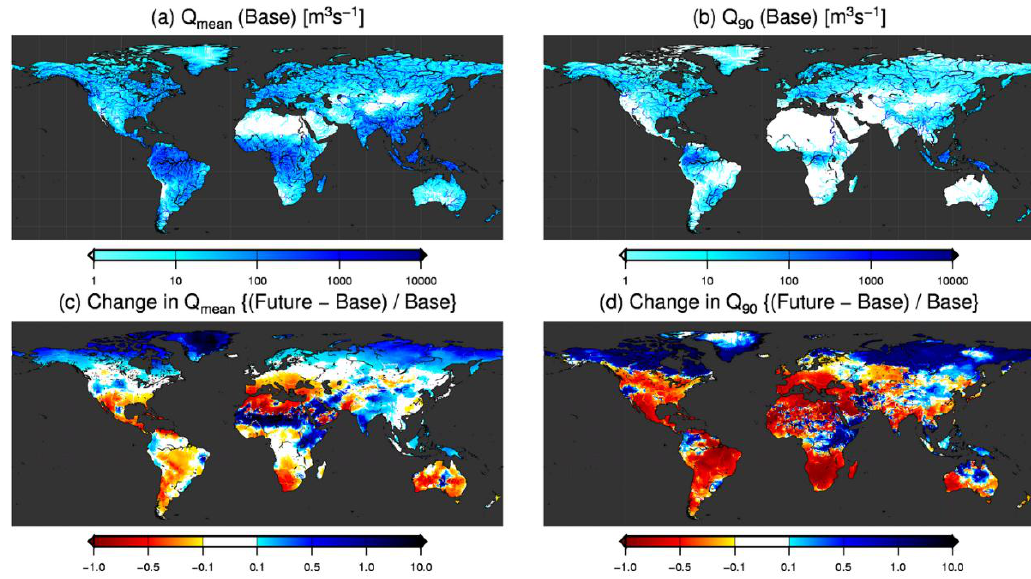
Figure 4. ( a ) Mean annual streamflow (Q mean ) and ( b ) 90th percentile daily streamflow (Q 90 ) during the base period (2006–2025). Changes in ( c ) Q mean and ( d ) Q 90 between the base period and future